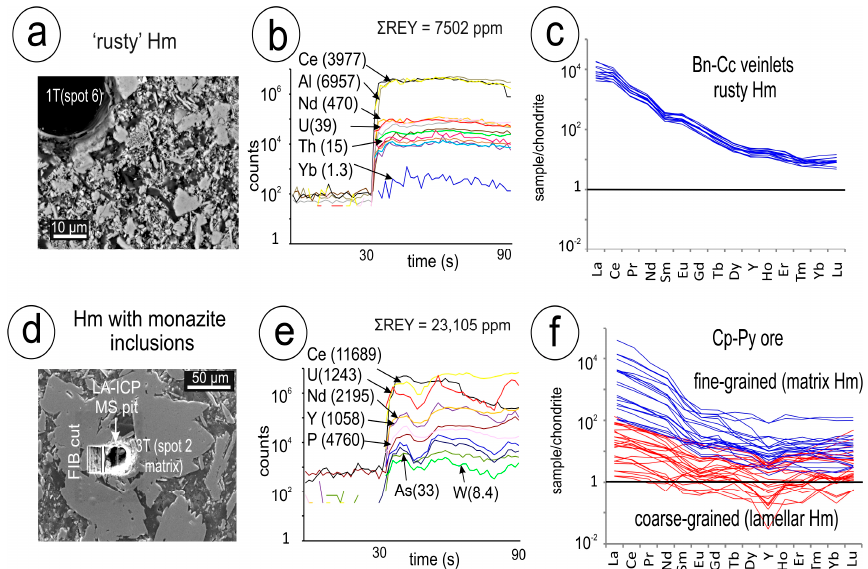
Figure 2. ( a ) Secondary electron (SE) image of fine ‐ grained rusty hematite (Olympic Dam; OD). Note size of laser spot relative to grain size; ( b ) time ‐ resolved depth profile showing ‘flat’ signals for most elements interpreted to he hosted in the hematite lattice; ( c ) chondrite ‐ normalized REY fractionation trends for this type of hematite; note coherent, readily interpretable trends; ( d ) SE image of coarser hematite aggregate containing inclusions of monazite (see Figure 3a–d; OD); ( e ) time ‐ resolved depth profile for spot in (d) showing rough signals indicative of inclusions during ablation. This hematite is not zoned with respect to trace elements; ( f ) chondrite ‐ normalized REY fractionation trends for the hematite in the same sample shown in (d,e) separated by grain size. There is an increase in Σ REY with the fine ‐ grained hematite in the matrix, which shows similar REY profiles with the rusty hematite. Note however their wider range relatively to the finest, rusty hematite in (c).